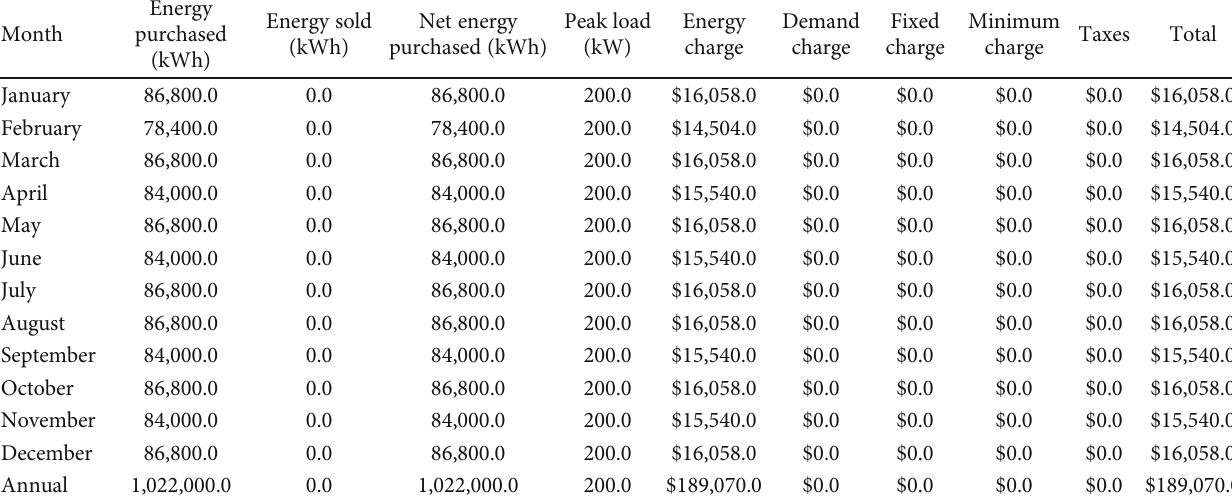
Table 4: Utility monthly summary — current system.